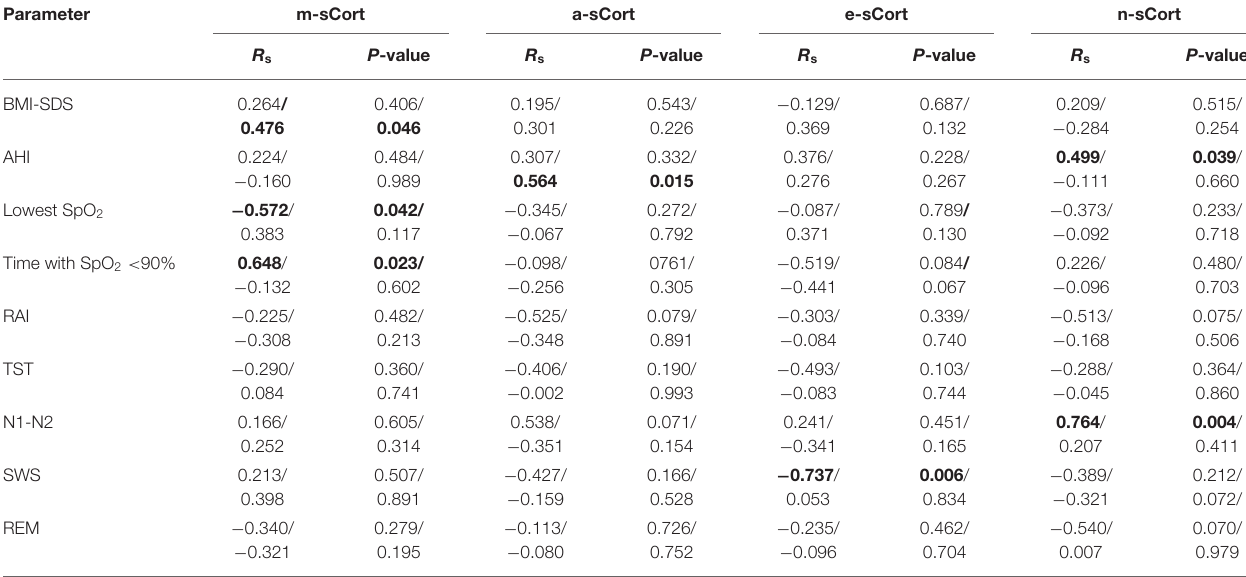
TABLE 3 | Cortisol level correlations both with body mass index (BMI) and polysomnography indices in obese adolescents with/without obstructive sleep apnea (OSA).